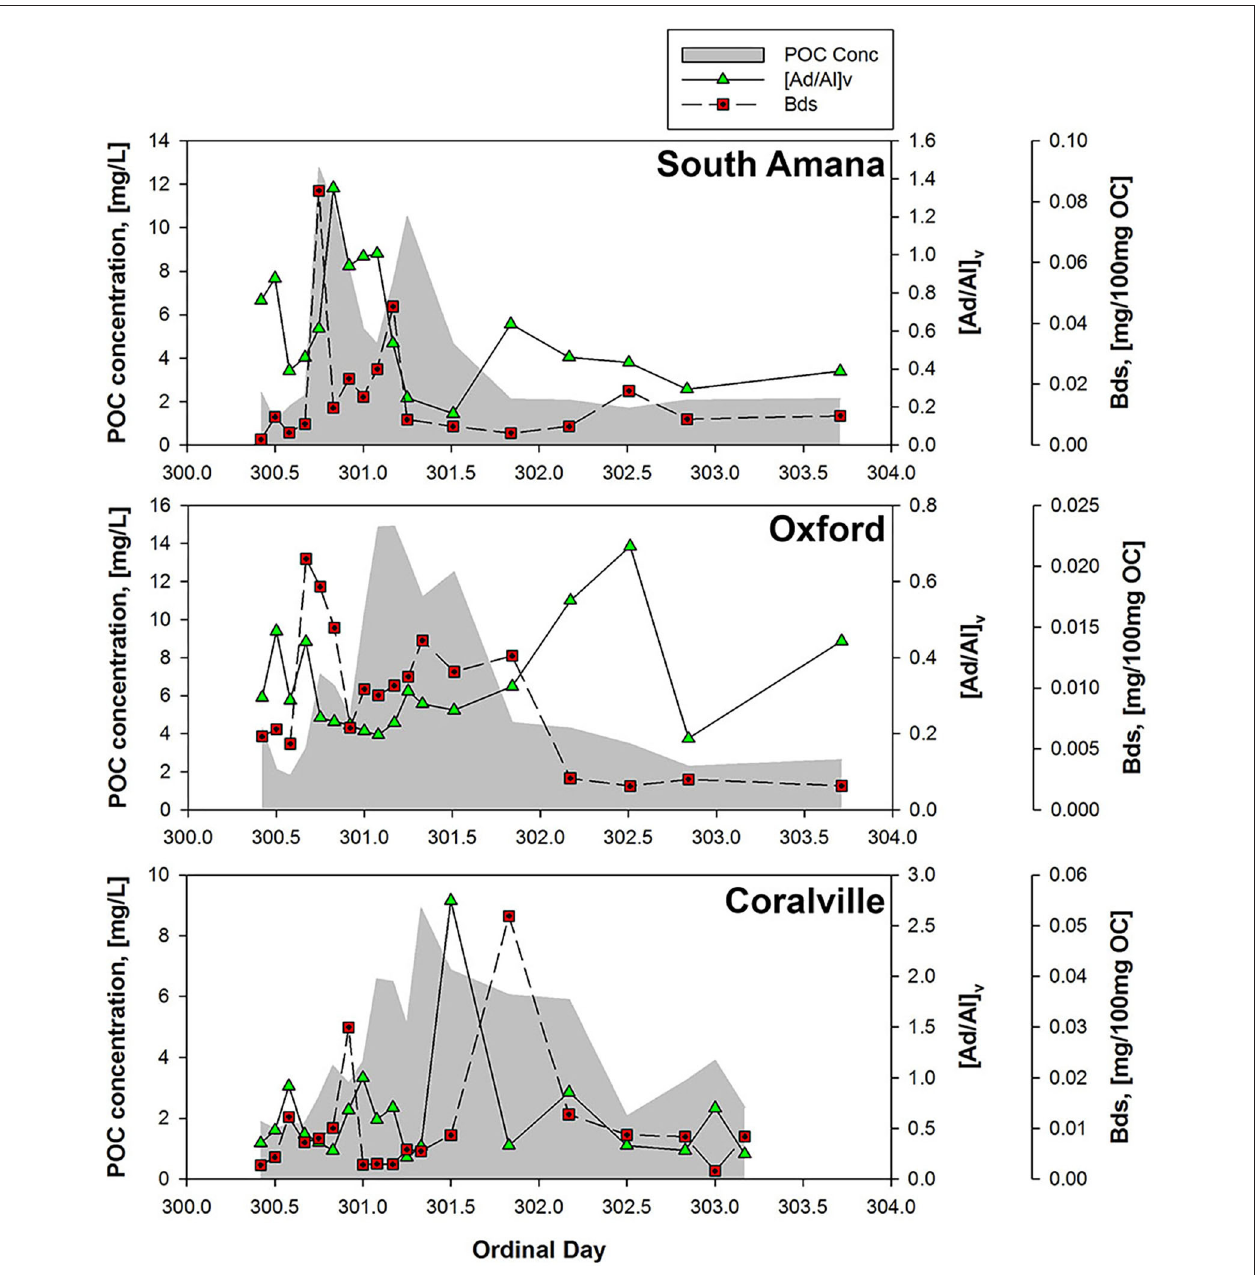
FIGURE 7 | POC concentrations and degradation tracers ([Ad/Al] v ratios and Bds concentrations). Increases in [Ad/Al] v or Bds indicate degradation of lignin or soil organic